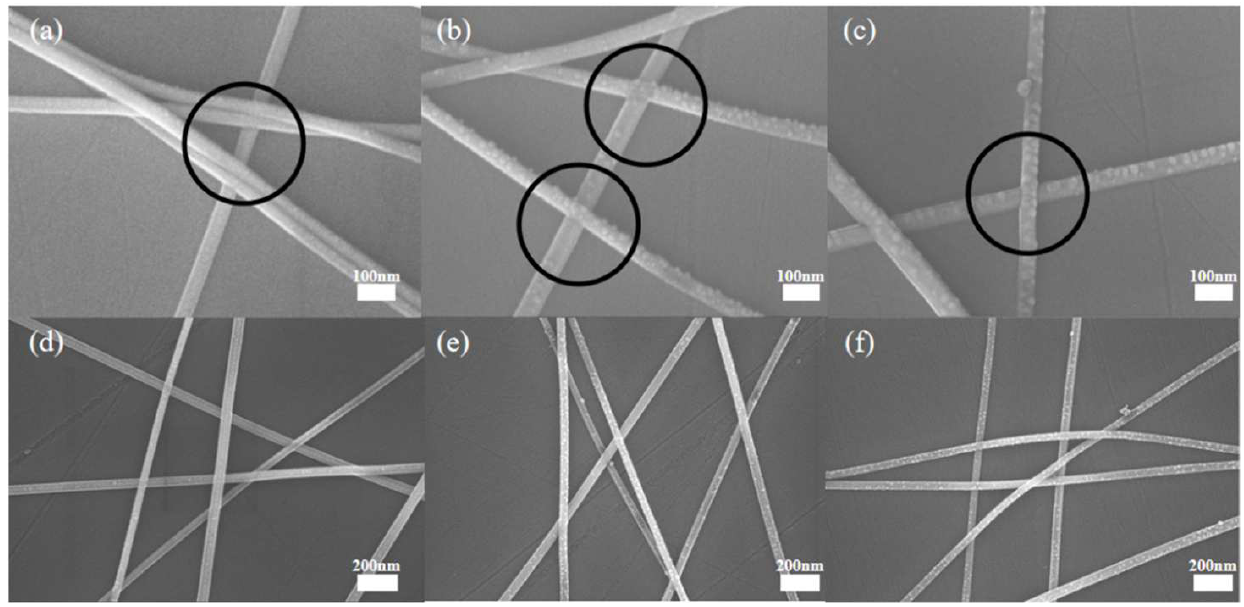
Figure 5. SEM image of AgNWs: ( a – c ) are oblique (30°) SEM images to observe the overlapping of AgNWs, ( d – f ) are the inclined plane SEM images to observe the precipitation of AgNW small particles. ( a , d ) have UV irradiation for 0 min, ( b , e ) for 1 min, and ( c , f ) for 3 min.